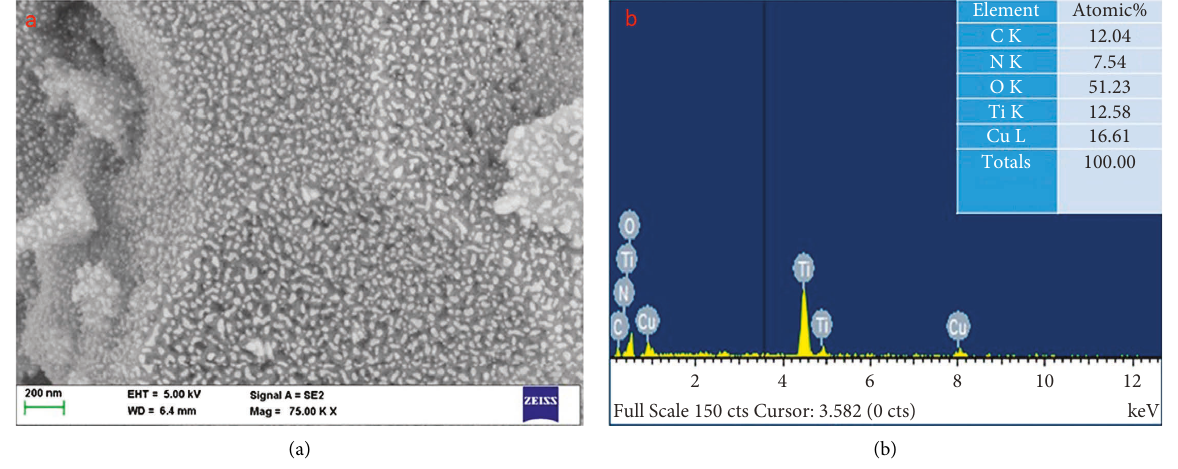
Figure 2: FESEM (a) and EDAX (b) images of